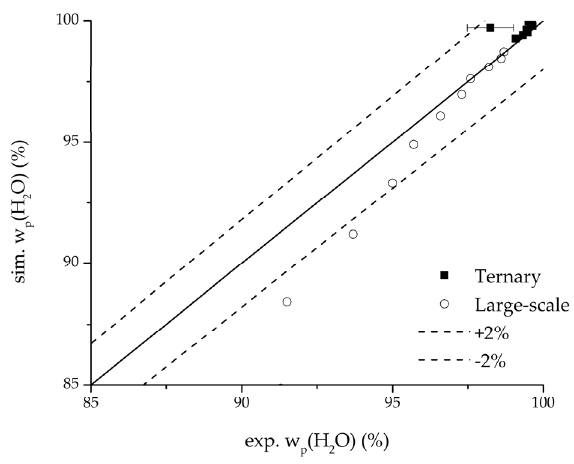
Figure 22. Parity plot between the experimental and simulated water mass fraction (feed) for the ternary system at 95 °C feed temperature.